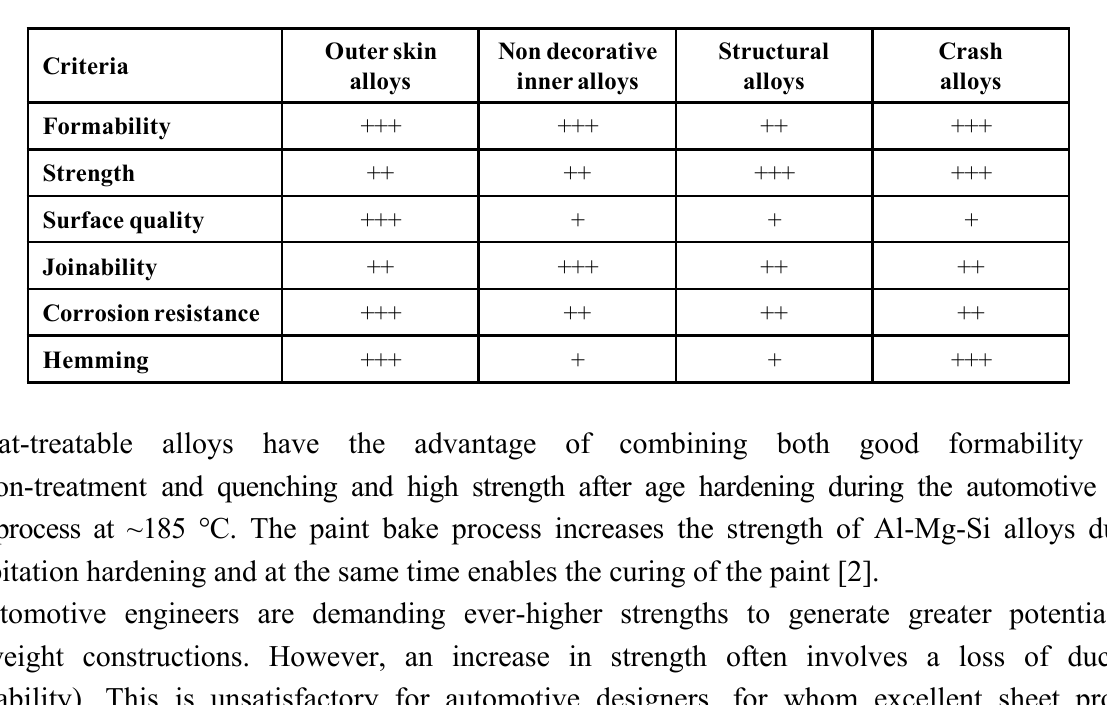
Figure 1. Property criteria for Al-Mg-Si sheet alloys for body-in-white applications [2,3].